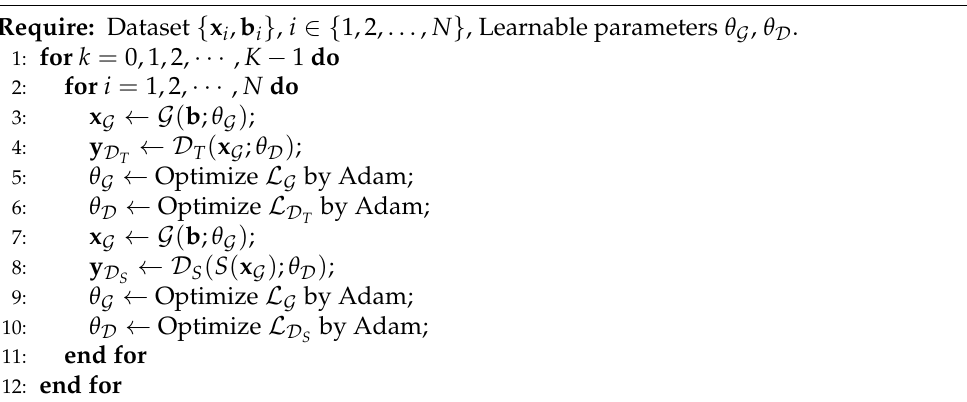
Figure 2. The schematic diagram of convergence curves for different discriminators. The red and blue curves represent only the simple image discriminator or sparse-prior discriminator. The yellow curve is the convergence route of our dual-branch discriminator. Algorithm 1 The training processing of